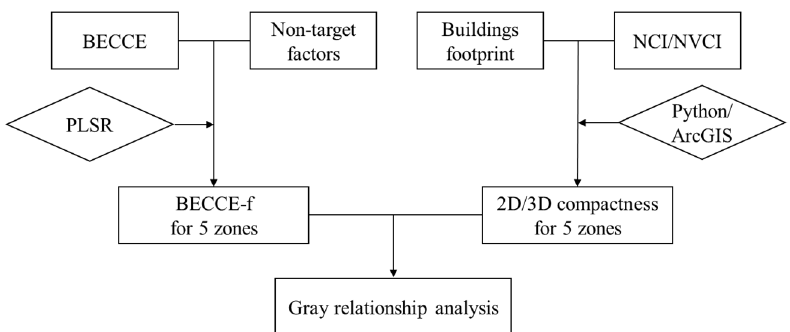
Figure 1. Flow chart of the basic methodology.